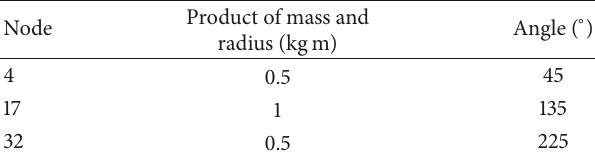
Table 4: Unbalance mass.